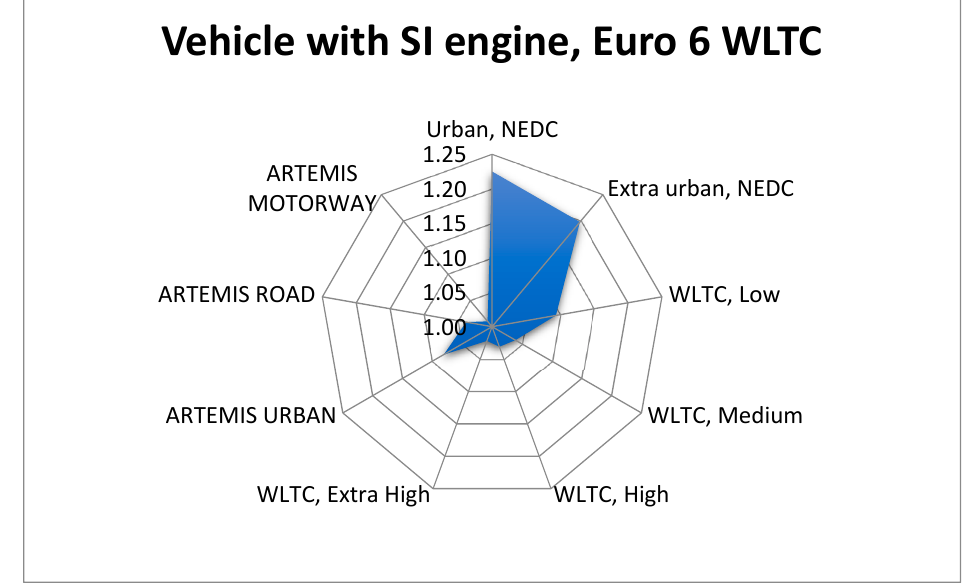
Figure 9. The median of the λ in driving cycles for a vehicle equipped with spark ignition engine, Euro 6 WLTP.